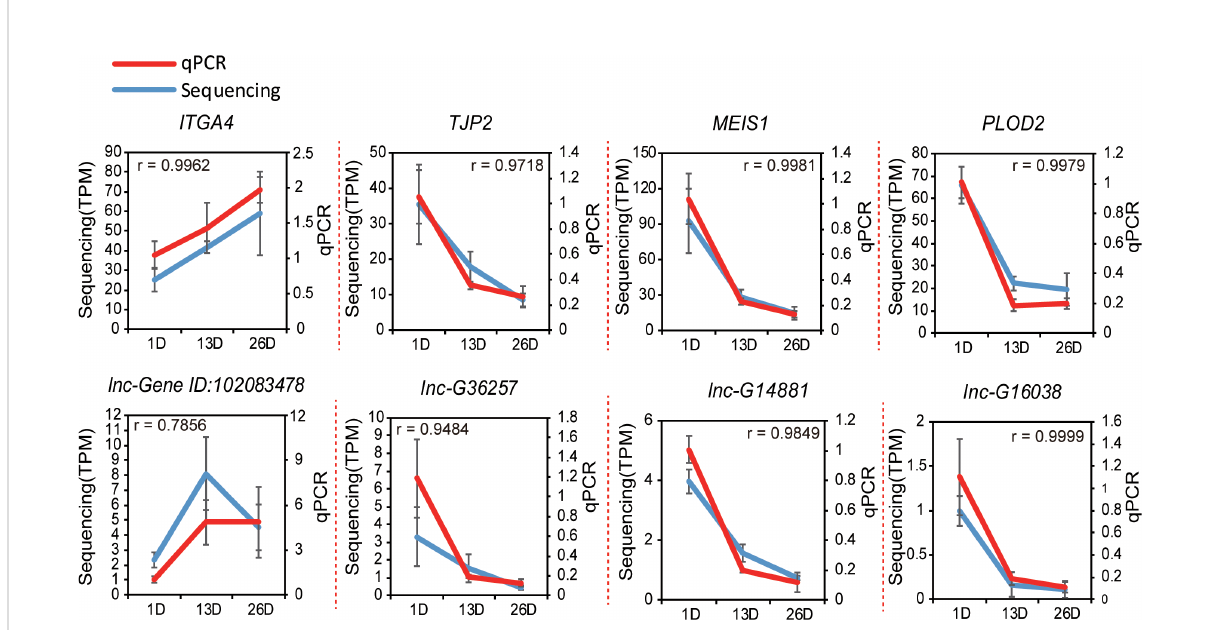
FIGURE 9 Validation of the sequencing data using qPCR. Four randomly selected protein coding genes and four lncRNAs in pigeon BFs were validated by real-time qPCR (n = 3). The Pearson product – moment correlation coef fi cient (r) was calculated using